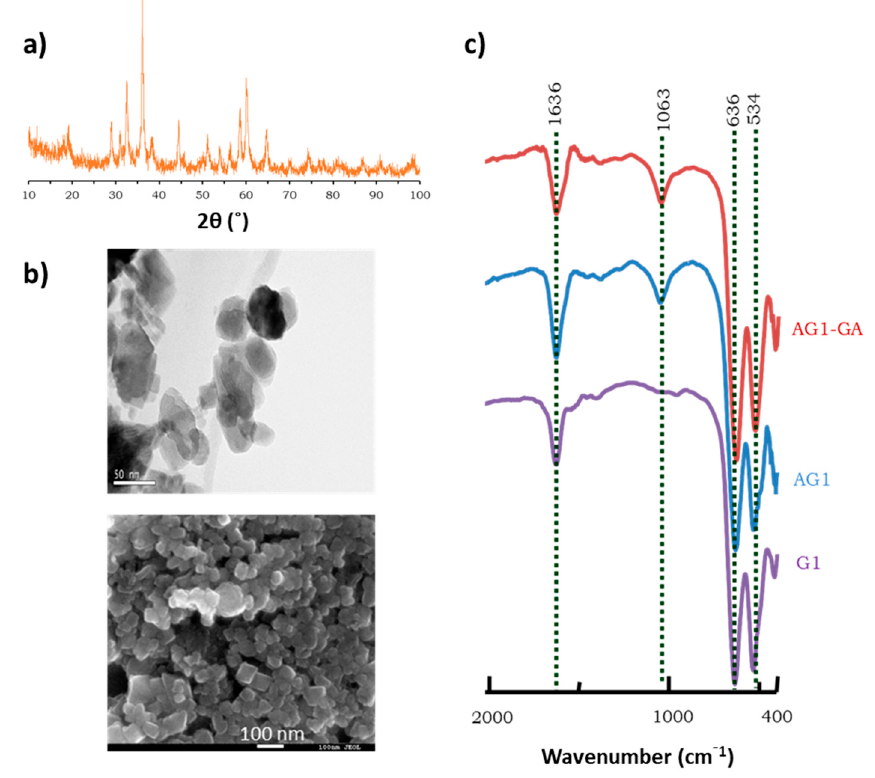
Figure 2. Characterization of the G1 carrier. ( a ) X-ray diffraction (XRD) pattern of G1. ( b ) TEM (upper) and SEM (lower) micrographs of G1. ( c ) FTIR spectra of G1, AG1, and AG1-GA.